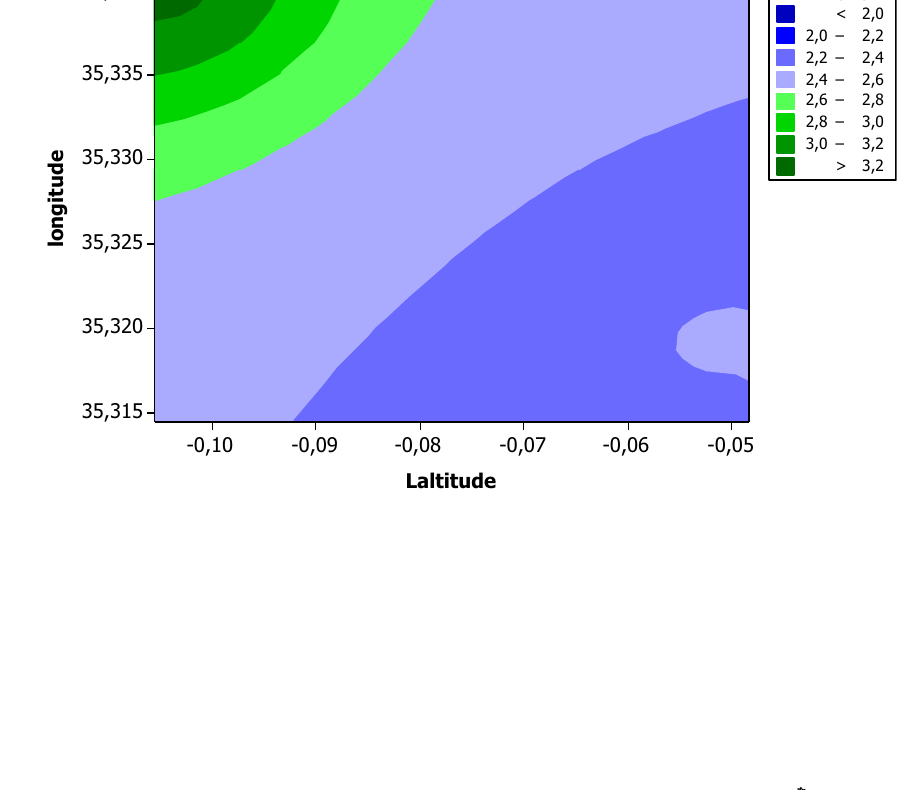
Fig. 7 Spatial variation of electrical conductivity in spring sources